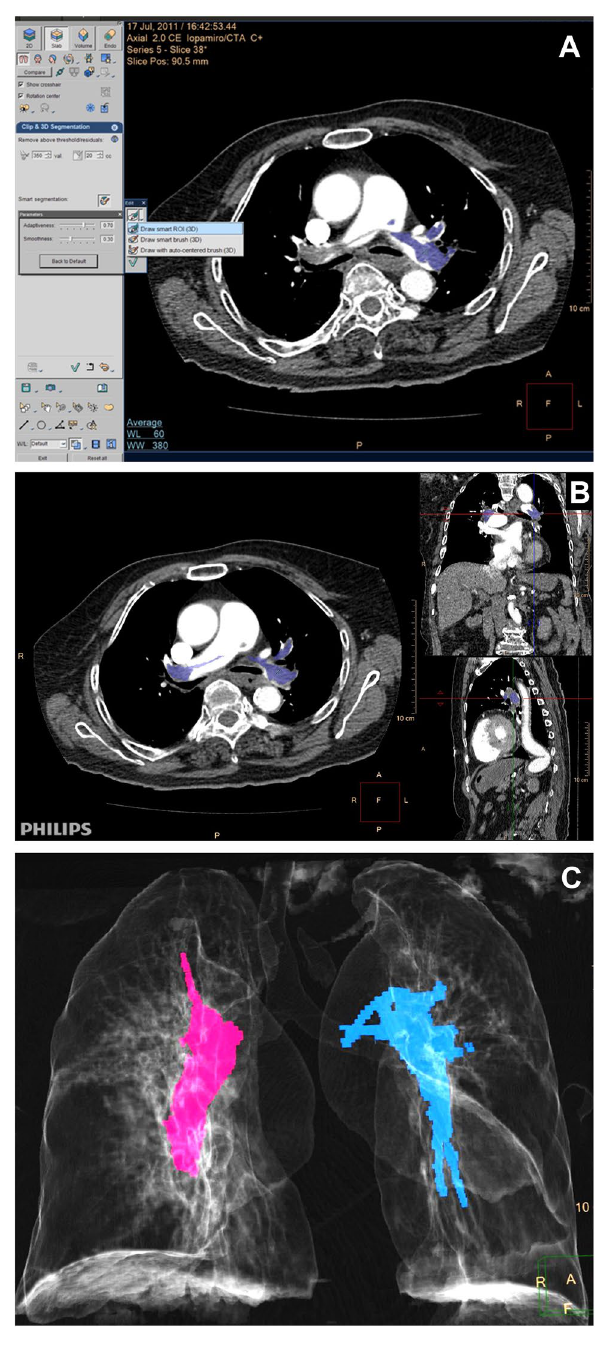
Figure 5. ( A ) 3D segmentation method (Draw smart ROI) was used to semi-automatically measure the volume of thrombus. ( B ) The boundaries of thrombus was checked visually on axial, coronal, and sagittal planes. ( C ) A 75-year-old female with high D-dimer (7898 mg/l) and mild elevated Troponin-I (0.64 ng/ml). 3D CT image quantification revealed large emboli burden in right pulmonary artery (14.3 cm 3 , pink color) and left pulmonary artery (15.03 cm 3 , blue